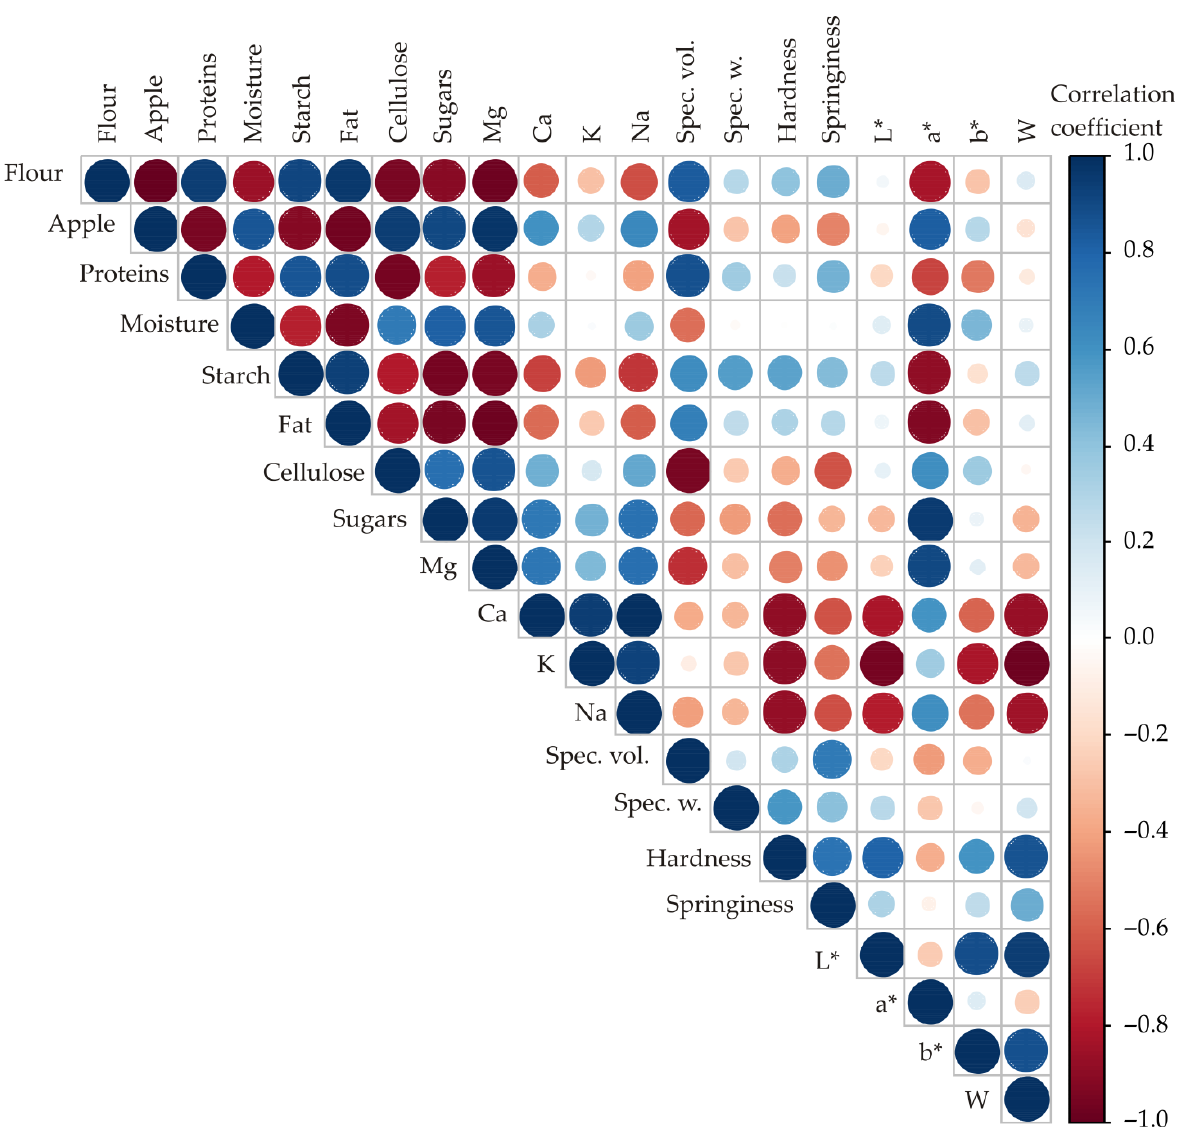
Figure 2. Color correlation diagram between all tested responses of muffins with additions of apple and OT apple powder .